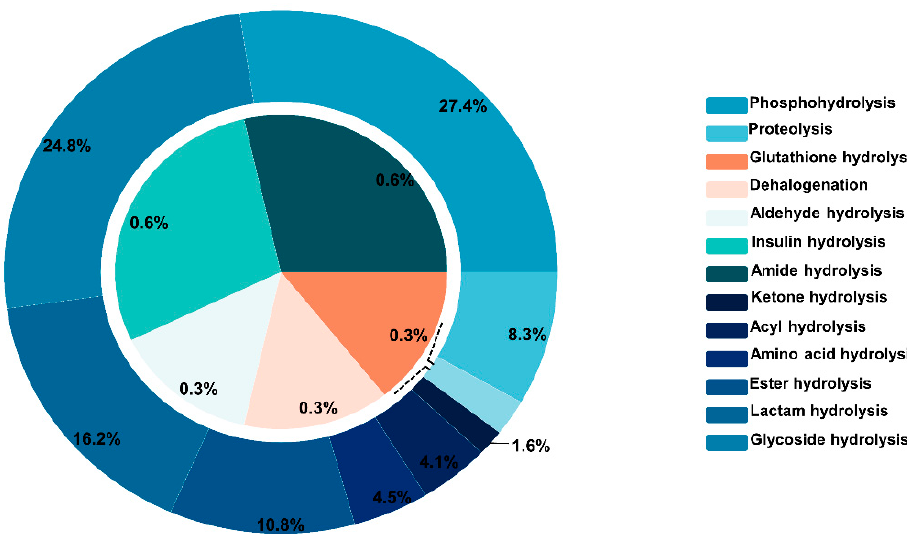
Figure 1. Distribution of hydrolysis reaction types involved in the data set.